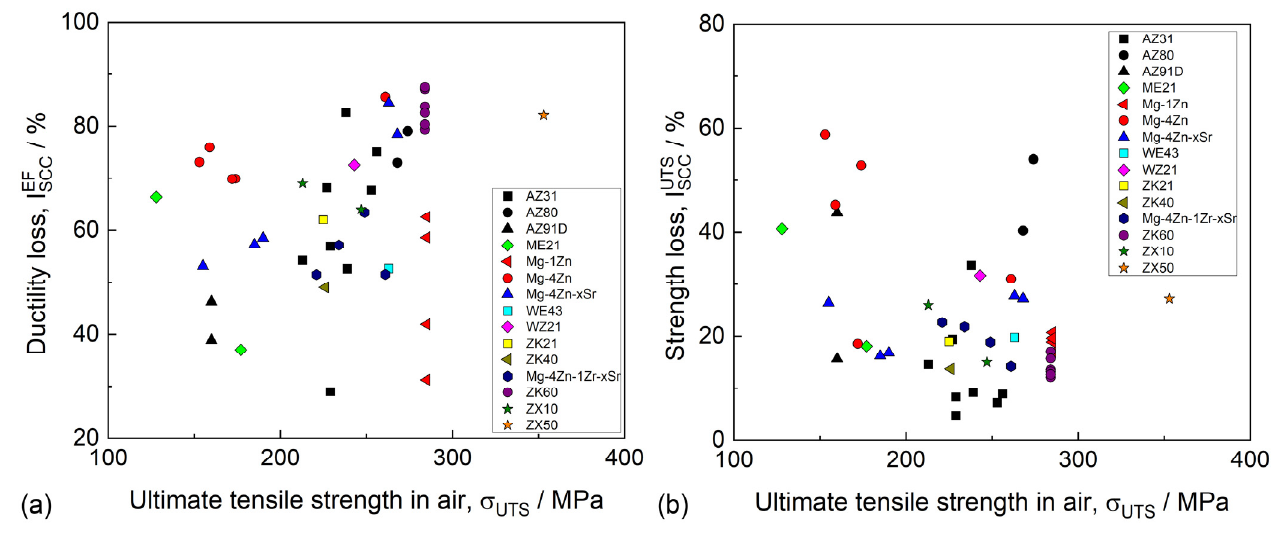
Figure 8. The relationships between the ductility and strength of the biodegradable Mg alloys SSRT- tested in SBFs in terms of SCC susceptibility indexes ( a ) and the absolute values of ultimate tensile strength and elongation to failure ( b ); data are imported from Table 5 and the references therein.